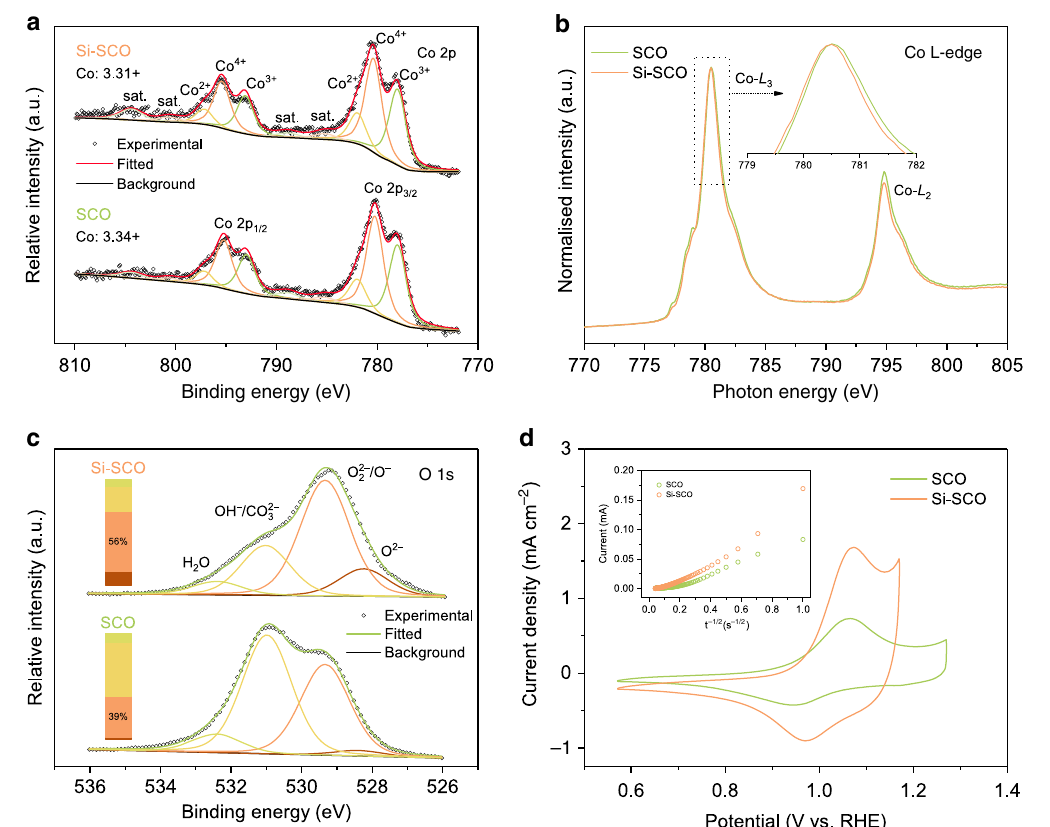
Fig. 4 Chemical and electrochemical characterisations of Si-incorporated strontium cobaltites. a Co 2 p core-level XPS spectra of SCO and Si – SCO, with peak fi tting results based on multiple cobalt species. Here sat. denotes satellite peaks. b Co L-edge NEXAFS spectra of SCO and Si – SCO. Inset of b shows the Co L 3 -edge spectra in an expanded photon energy scale. c O 1 s core-level XPS spectra of SCO and Si – SCO, with peak fi tting results illustrated in the stacked columns. d CV curves of SCO and Si – SCO in Ar-saturated 6 M KOH, where redox peaks indicate the electrochemical oxygen intercalation/de- intercalation. Inset of d shows the chronoamperometry data ( i vs. t – 1/2 ) used for the calculation of oxygen ion diffusion coef fi